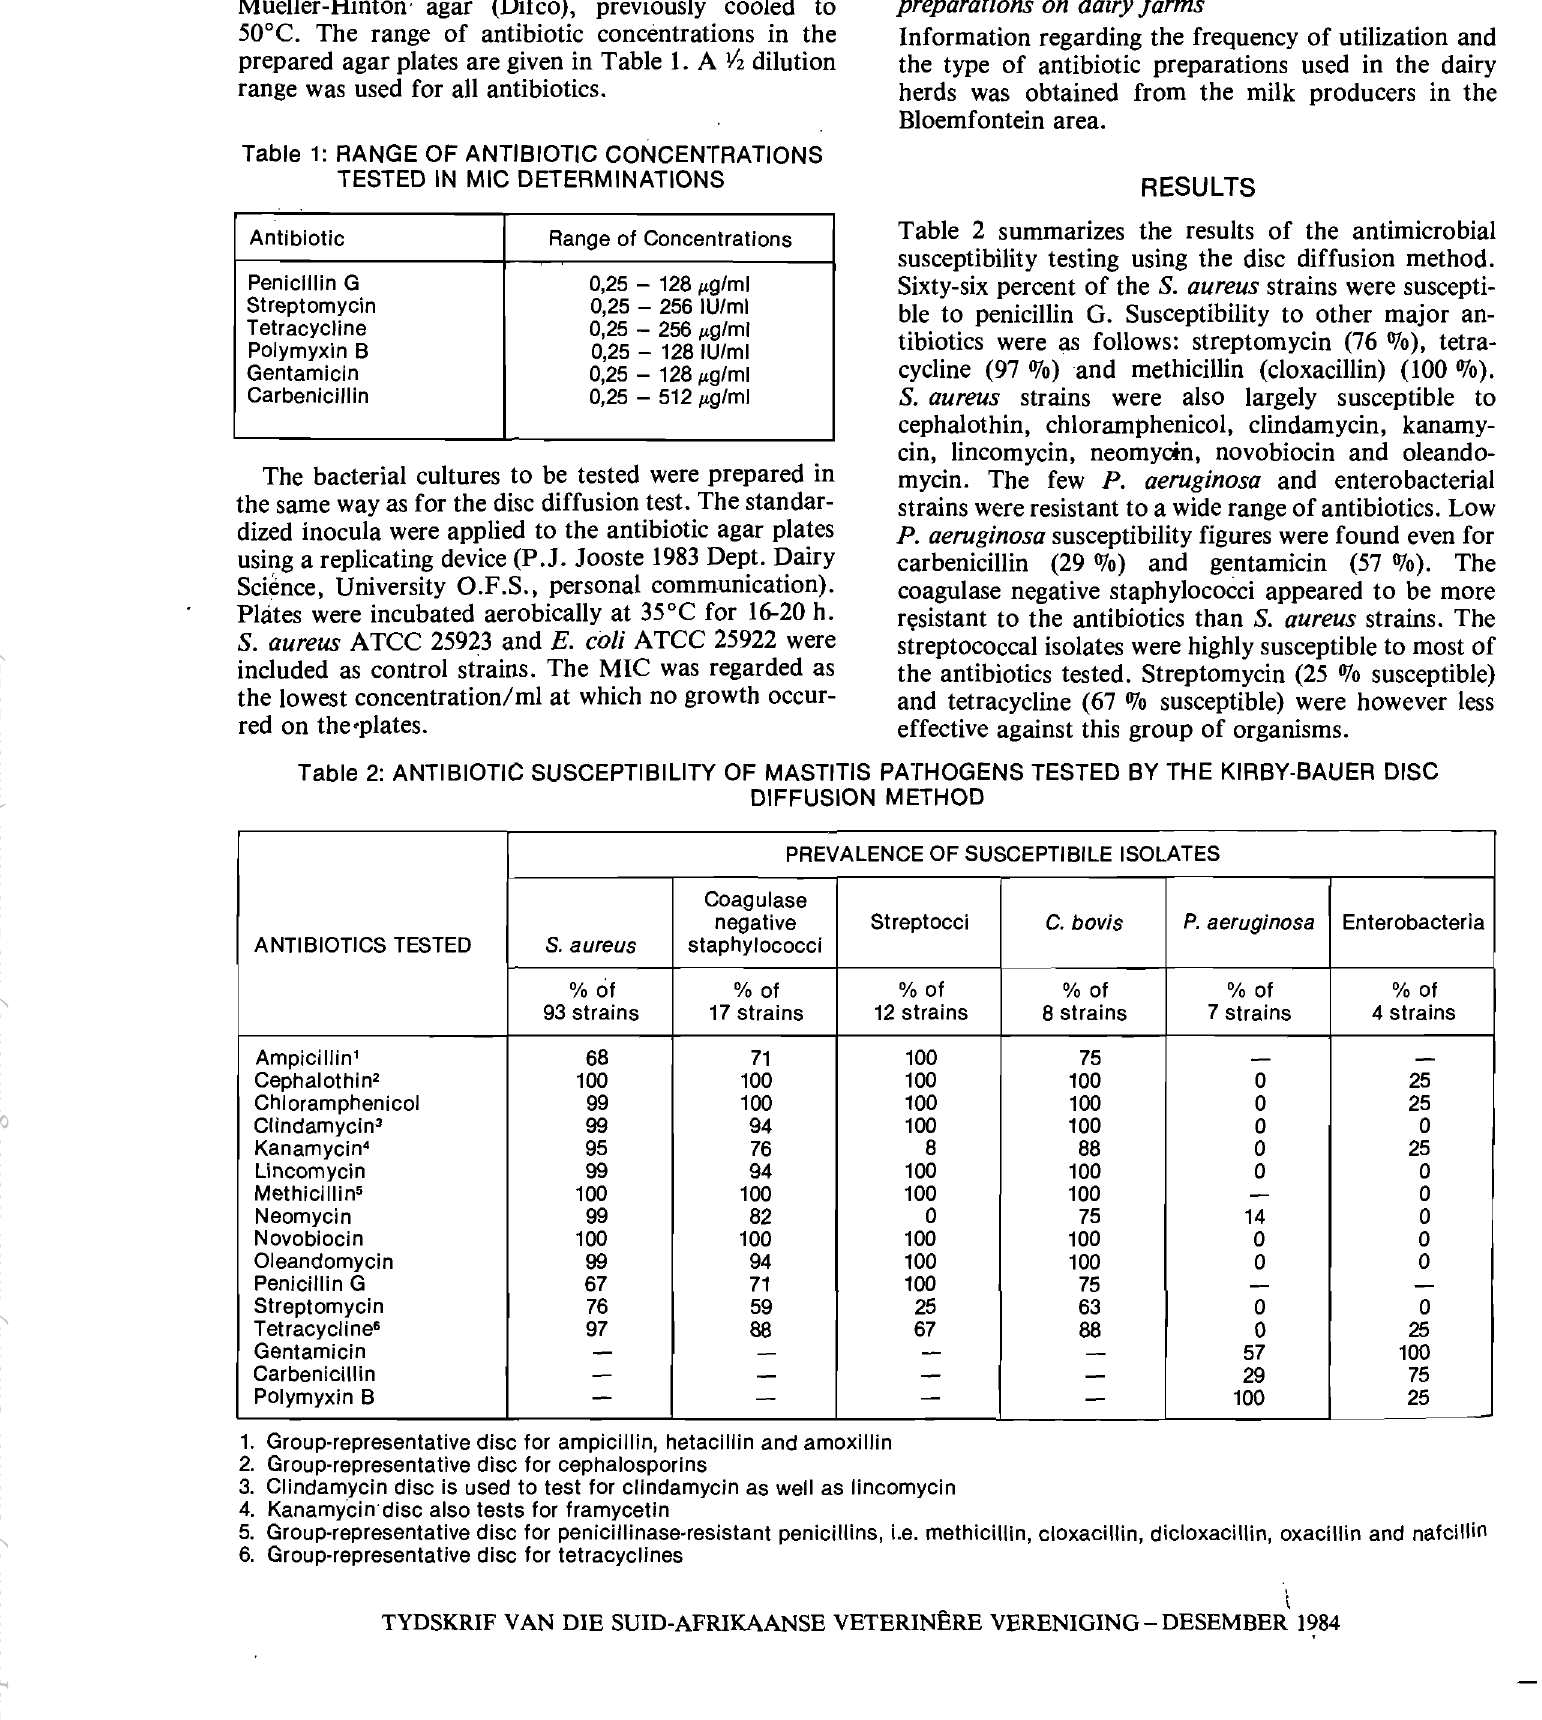
Table 2: ANTIBIOTIC SUSCEPTIBILITY OF MASTITIS PATHOGENS TESTED BY THE KIRBY-BAUER